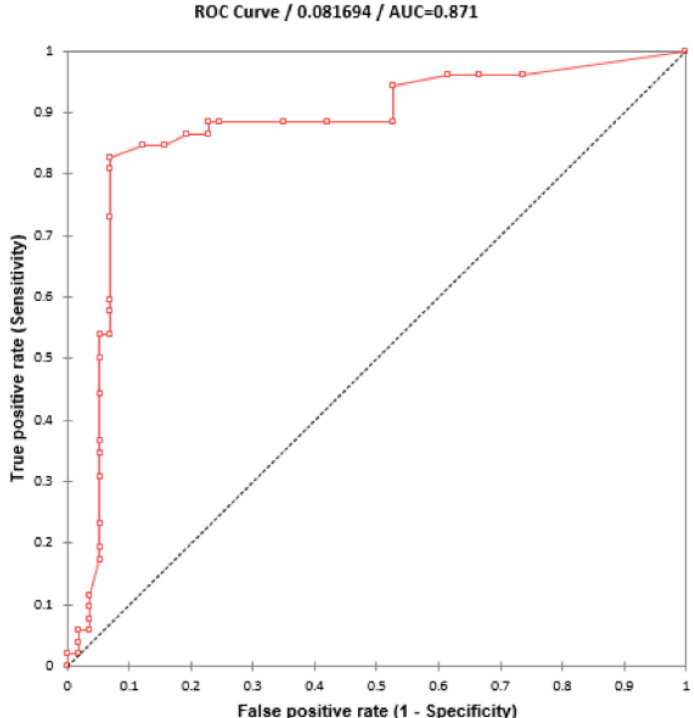
Figure 4. ROC curve for diagnosis of RR-TB based on HRM analysis. The ∆ Tm cutoff value at 0.245 ◦ C was established to differentiate between rifampicin-resistant M. tuberculosis (RR-Mtb) and rifampicin-susceptible M. tuberculosis (RS-Mtb).